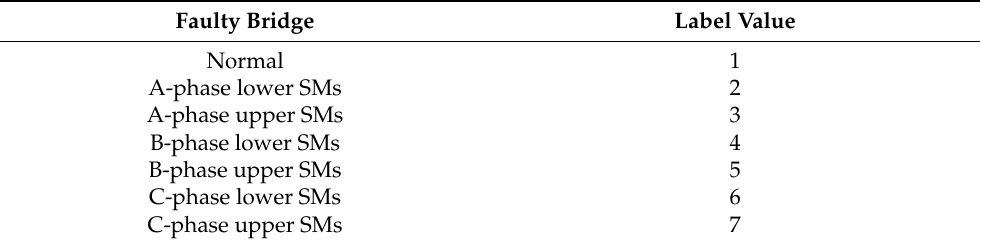
Table 3. MMC health conditions